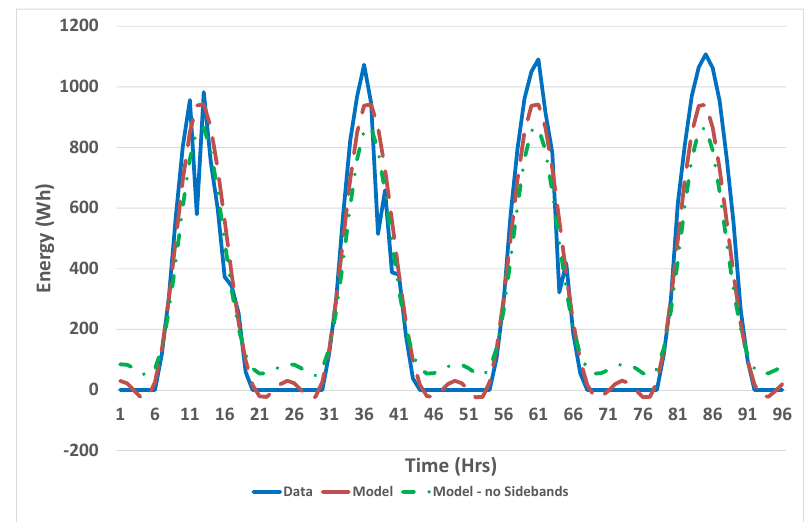
Figure 10. Comparison of Fourier series model with and without sidebands—summer in St